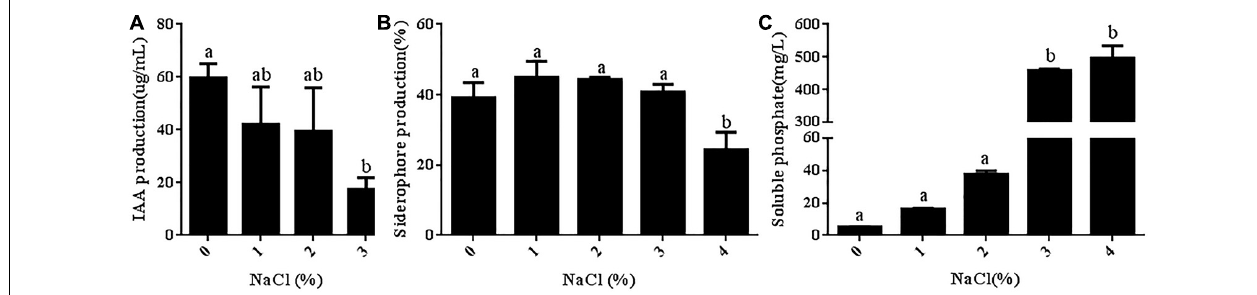
FIGURE 7 | Determination of JZ-GX1-related growth-promoting characteristics in the presence of different salt concentrations. (A) IAA content. (B) Siderophore content. (C) Phosphorus concentration. The vertical bars represent the standard deviations of the averages. One-way ANOVA was performed, and Duncan’s post hoc test was applied. Different letters indicate significant differences ( P < 0.05) among the treatments.